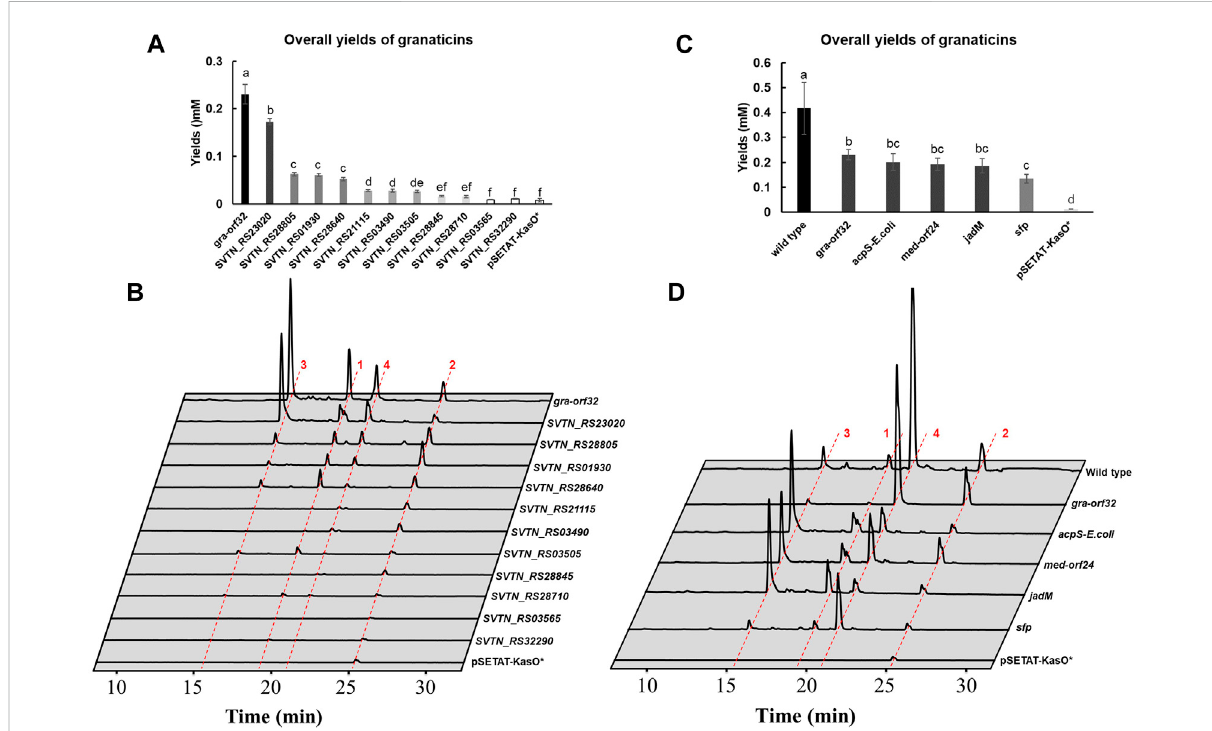
FIGURE 5 Overexpression of endogenous and exogenous PPTase genes in the mutant Δ gra-orf32 . 1 , granaticin; 2 , granaticin B; 3 , granaticinic acid; 4 , granaticinicacidB.TheUVabsorbancedatawerecollectedatthewavelengthof520 nm.Statisticalsigni fi cancesofquanti fi cationsweretestedat p < 0.05 and indicated on top of the columns. (A) Quanti fi cations of the mutant Δ gra-orf32 carrying an additional copy of different endogenous PPTase genesunderthestrongpromoter KasOp*. (B) HPLC metabolic pro fi lingofthemutant Δ gra-orf32 withoverexpressionofdifferentendogenous PPTasegenes. (C) Quanti fi cationsofthemutant Δ gra-orf32 withoverexpression ofselectedexogenousPPTasegenes. (D) HPLC metabolic pro fi ling of the mutant Δ gra-orf32 with overexpression of selected exogenous PPTase